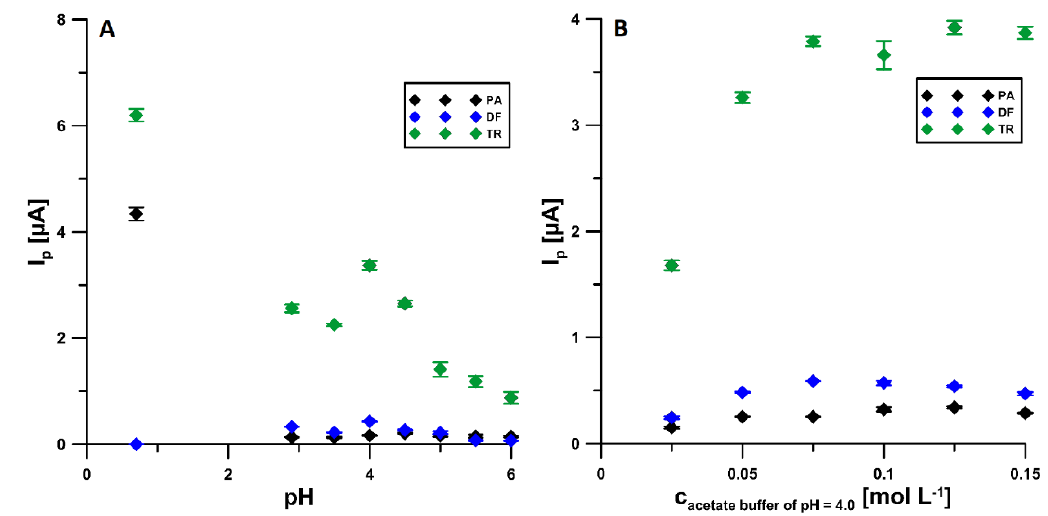
Figure 4. Effect of pH ( A ) and the concentration of the CH 3 COOH/CH 3 COONa buffer solution with a pH of 4.0 ± 0.1 ( B ) on the signals of 2 × 10 − 6 mol L − 1 PA, 1 × 10 − 7 mol L − 1 DF, and 2 × 10 − 5 mol L − 1 TR. The DPAdSV parameters as in Figure 1A.